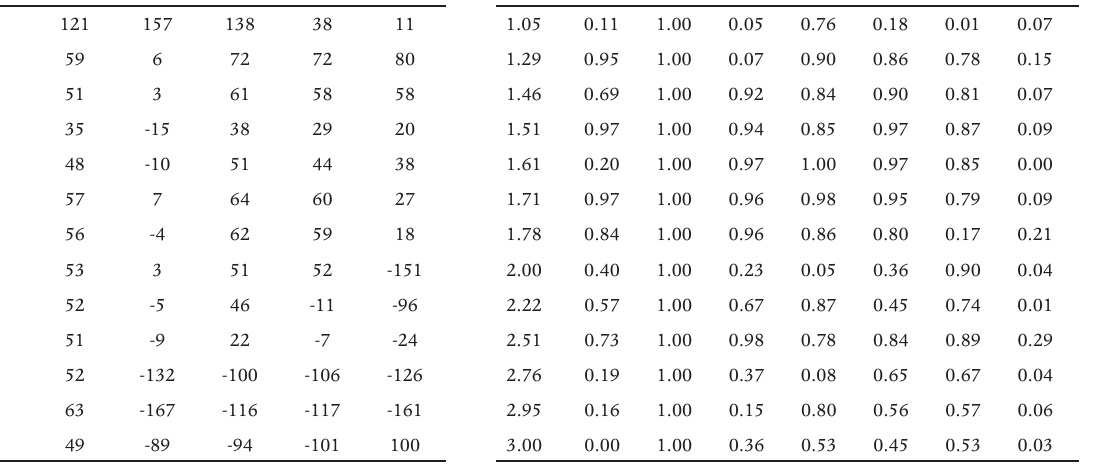
Table 7. Coherence function in C3 with reference to S19.